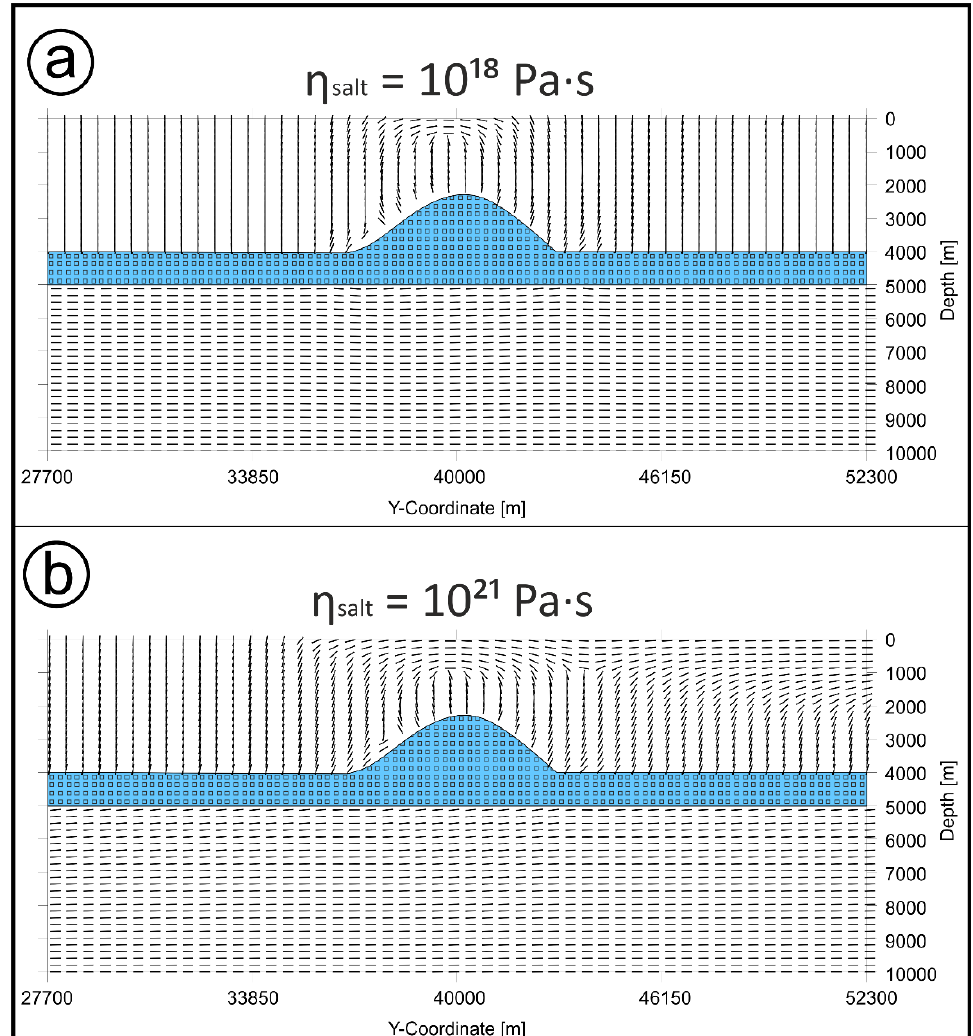
Figure 5. Orientation of S 1 along a vertical section (see P in Figure 1c) through the centre of a model with a salt diapir (x = 40000 m) for two different dynamic viscosities of the salt (blue layer). Shortening amounts to 400 m and is applied to the subsalt on the left. ( a ) Viscosity of 10 18 Pa·s (Model B-04d); S 1 is mainly vertical in the suprasalt and horizontal in the subsalt region. Some stress perturbations are observed in the suprasalt section near the top of the salt layer and above the diapir. ( b ) Viscosity of 10 21 Pa·s (Model B-07b); in comparison to ( a ), larger parts of the model in the suprasalt domain are characterised by a horizontal orientation of S 1 .